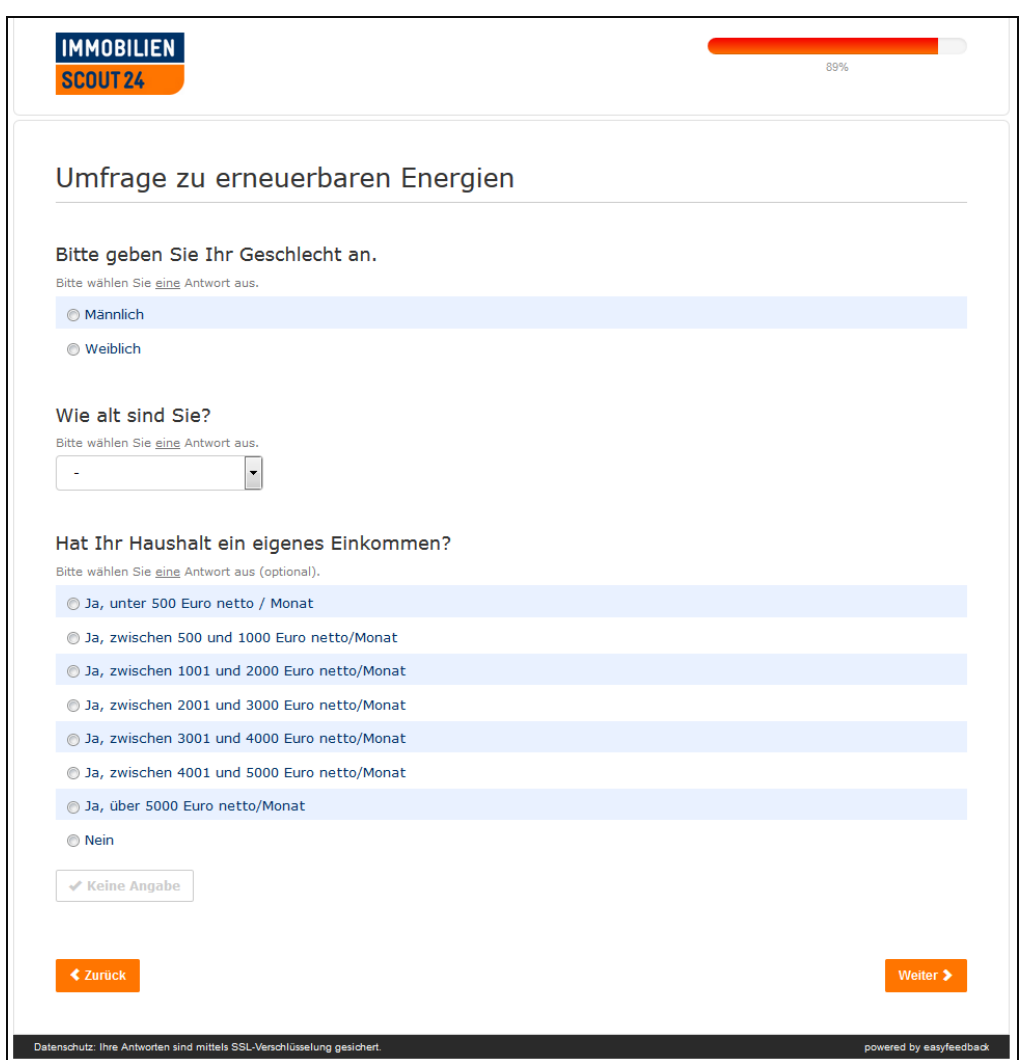
Figure A16. Screenshot of Questionnaire Page 15. Please indicate your gender. Please select one single